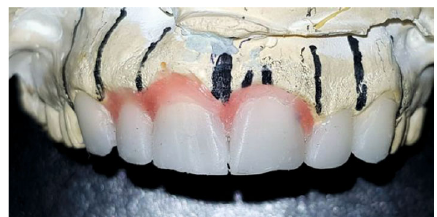
Figure 5: Initial wax-up showing the size/shape of the teeth. A new gingival level was placed.